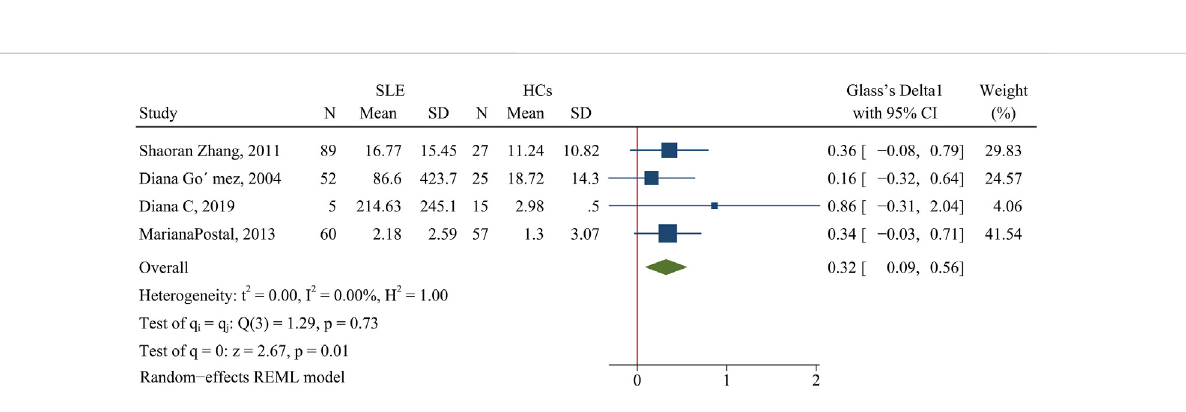
FIGURE 6 Forest plot of the concentration change of TNF- α in SLE patients compared with HCs. SLE, systemic lupus erythematosus; HCs, healthy controls.